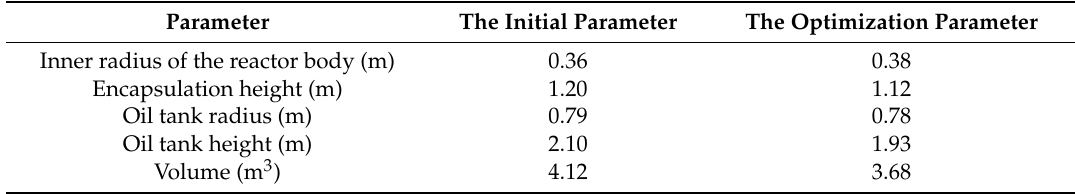
Table 3. The optimization design results of the reactor body and oil tank.